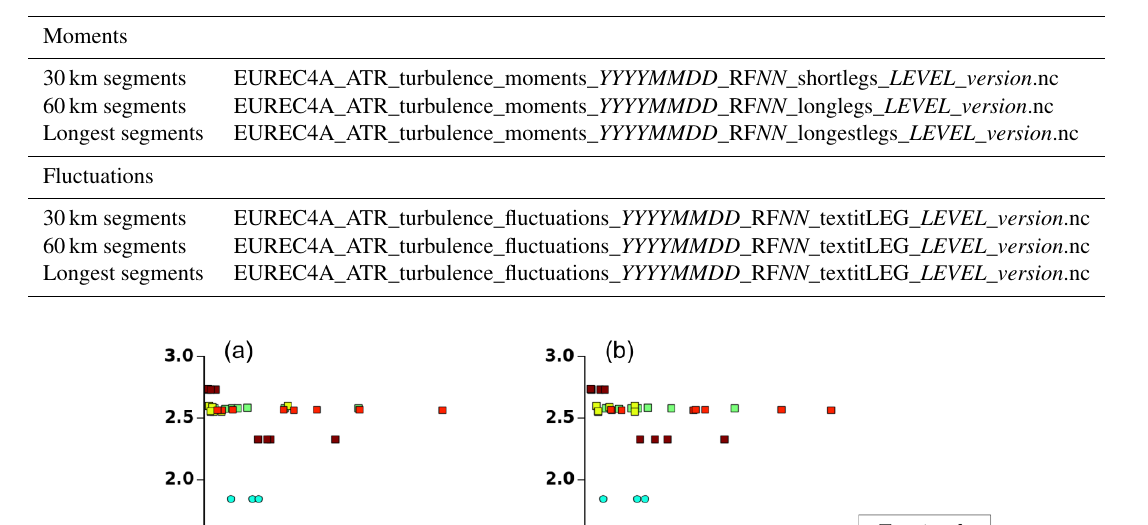
Table 3. File nomenclature. YYYYMMDD corresponds to the flight date (e.g., 20200202), NN to the flight number (e.g., 09), LEG to the segment identifier (e.g., R2B or l2c) and LEVEL to the level of data processing (L2 or L3).